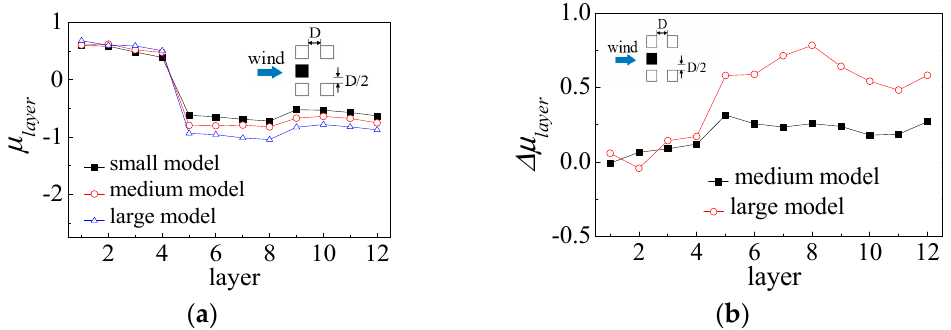
Figure 13. Wind tunnel test results of test condition 4. ( a ) Layer pressure coefficient; ( b ) relative error of layer pressure coefficient.